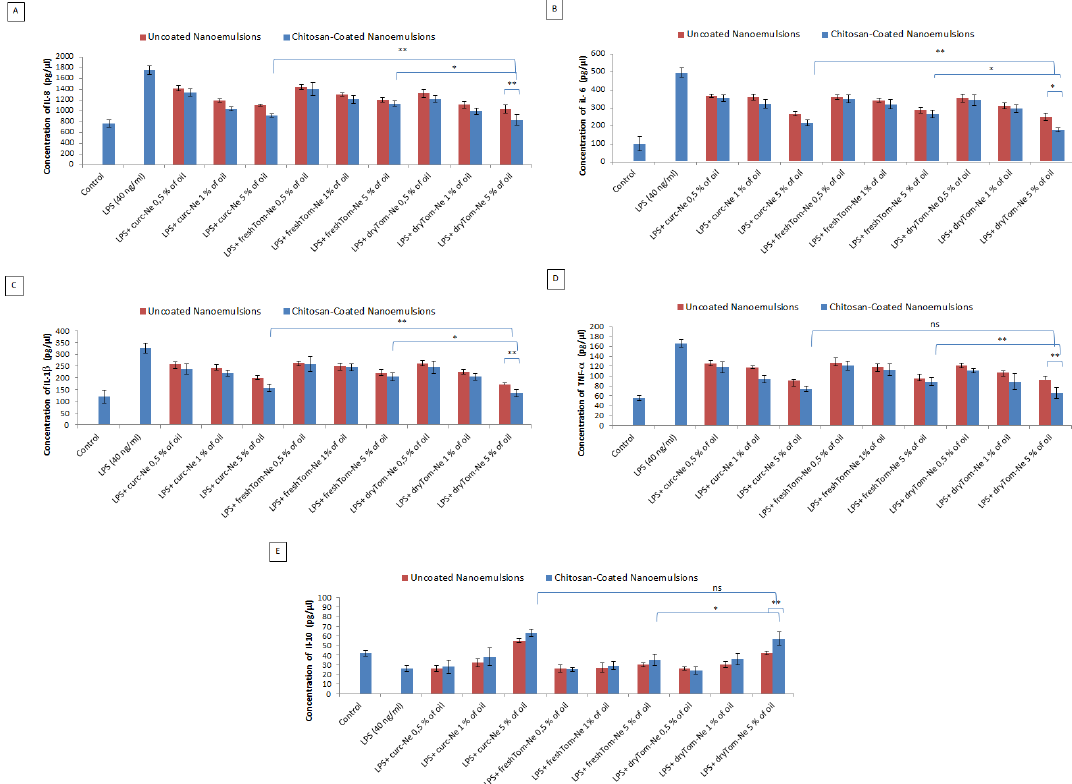
Figure 10. Anti-inflammatory effects of nutraceutical-loaded nanoemulsionson IL-8 ( A ), IL-6 ( B ), IL-1 β ( C ), TNF- α ( D ) and IL-10 ( E ) production of cardiomyoblasts (at a density of 1.2 × 10 5 cells/well). Cells were treated or not with 0.1 mL of a 0.5%, 1% and 5% of oil of chitosan-coated and uncoated nanoemulsions for 5 h before exposure to lipopolysaccharides (40 ng/mL) for 12 h. * p < 0.001, ** p < 0.05; ns: not significant.